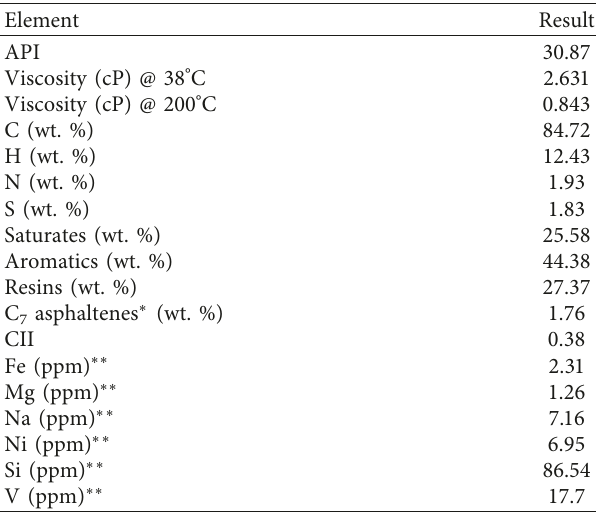
Table 2: Properties of sample 1.